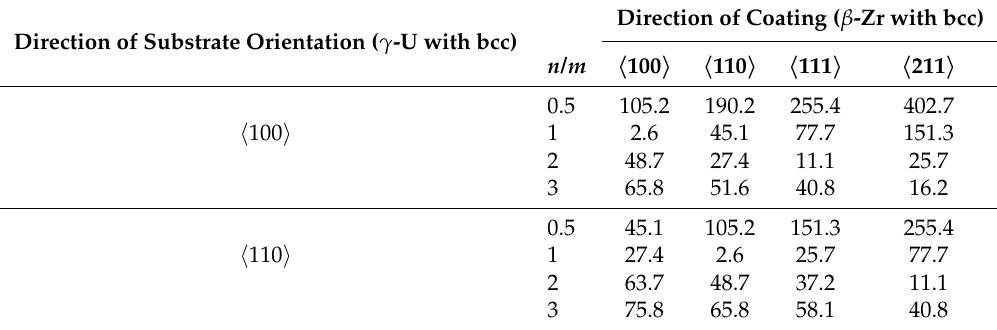
Table 2. Lattice misfit between coating and substrate in percentages. See text for more details. Direction of Coating ( β -Zr with Direction of Substrate Orientation ( γ -U with bcc)